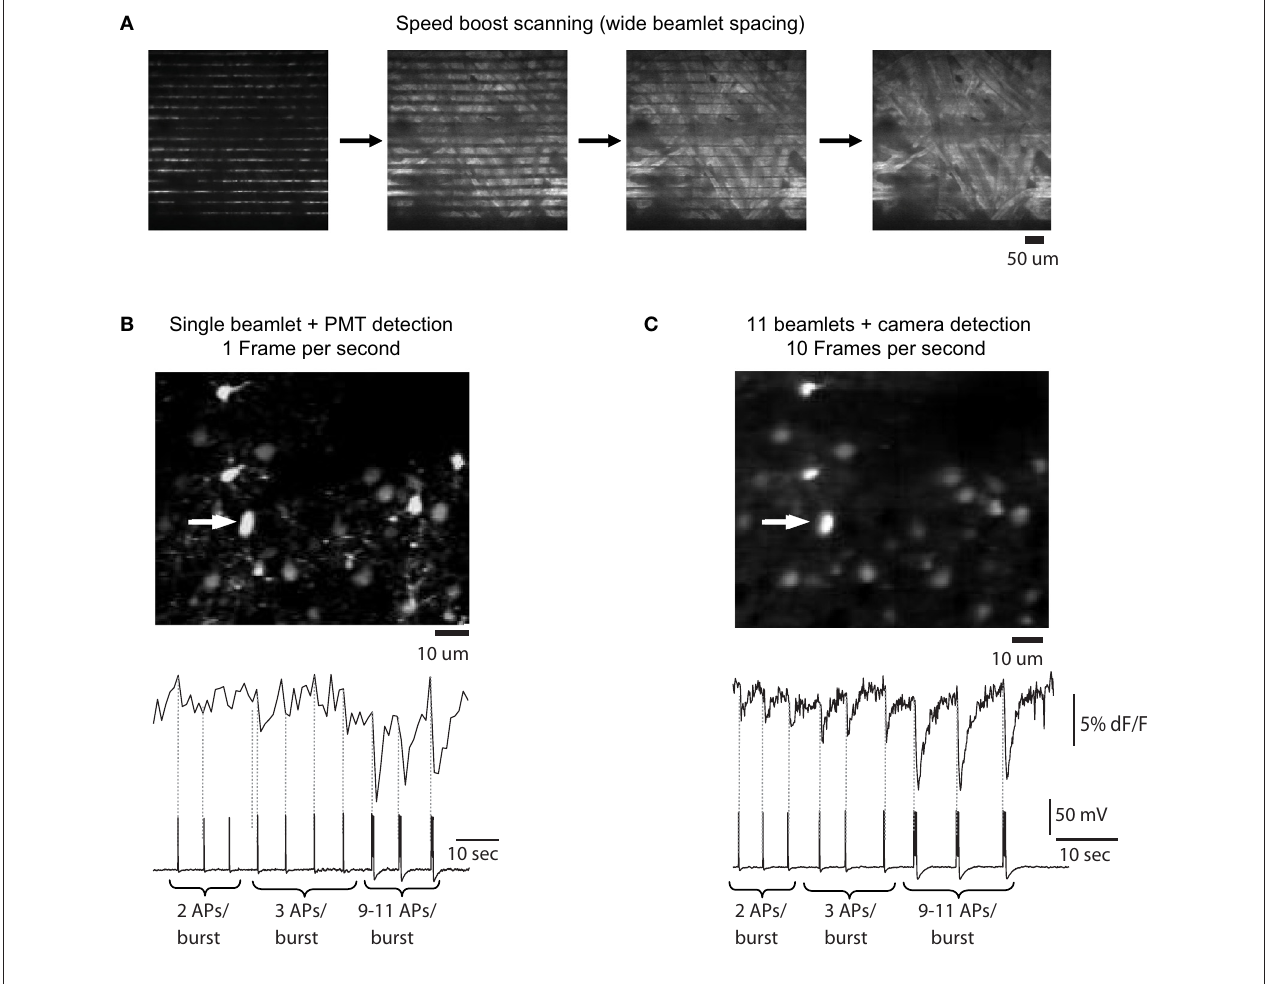
of increasing numbers of action potentials (number of action potentials per burst indicated below trace and timing indicated in imaging trace with dotted vertical line). Vertical axis of brightness trace in arbitrary brightness units, horizontal axis in seconds. (C) Vertical DOE scanning of a population of neurons using 11 beamlet excitation and imaging with a CCD camera. Movie collected at 10 frames per second. Note that calcium transients corresponding to times of bursts of two or three action potentials are easily visible in the calcium indicator tracing produced by DOE-based imaging and are less clear with single beam raster scan. Furthermore, while calcium transients produced by 9–11 action potentials per burst were easily distinguishable in both cases, they were found o have a 2.15-fold greater signal to noise ratio in the case of speed boost